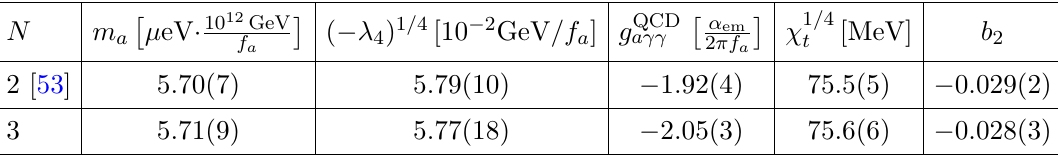
Table 2 . Summary of the main numerical results of the present work shown in the third line. For comparison we also show the results in the second line obtained in the framework of the SU(2) CHPT [53]. For the axion-photon coupling g a(cid:13)(cid:13) , only the model-independent part, denoted by g QCD , is a(cid:13)(cid:13)